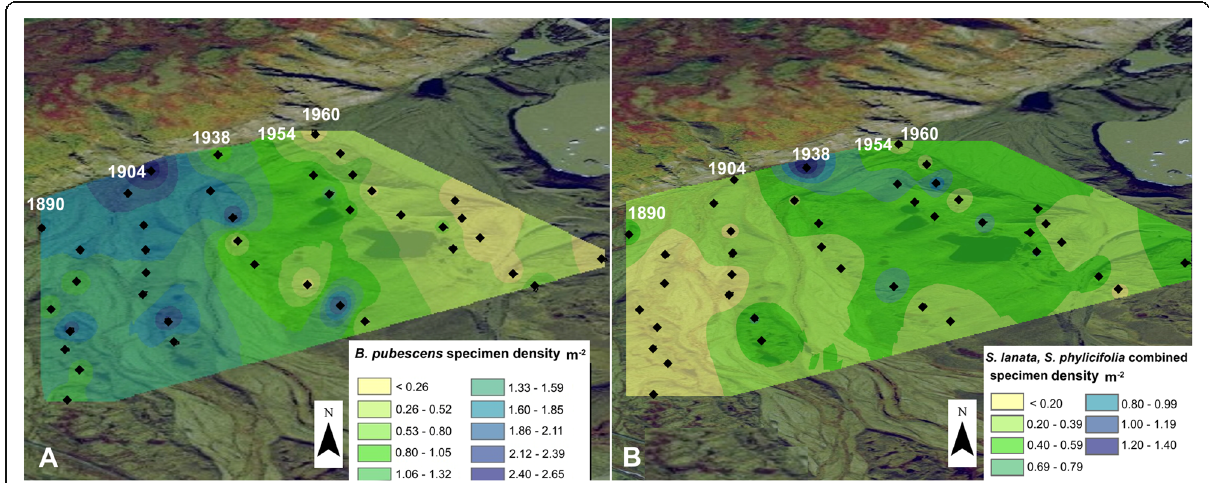
Fig. 2 Contour maps of the density of specimens of B. pubescens ( a ) and combined Salix spp. ( b ) at each station (each station = 100 m 2 ), with interpolation of the density of individuals per m 2 between. Maps constructed with the ArcGIS 10.2 software, based on map in Fig. 1